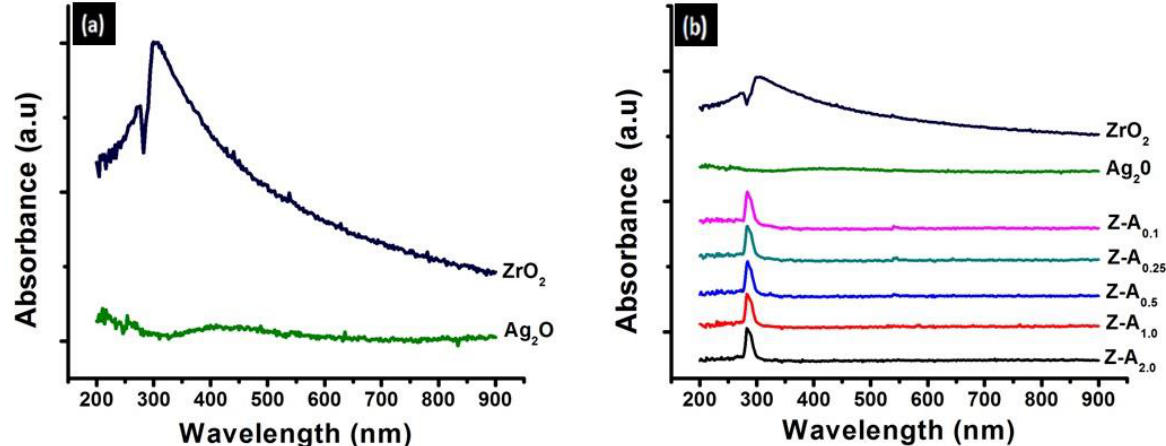
Figure 1. UV-visible absorption spectra of ( a ) ZrO 2 and Ag 2 O ( b ) Z-A nanoparticles.